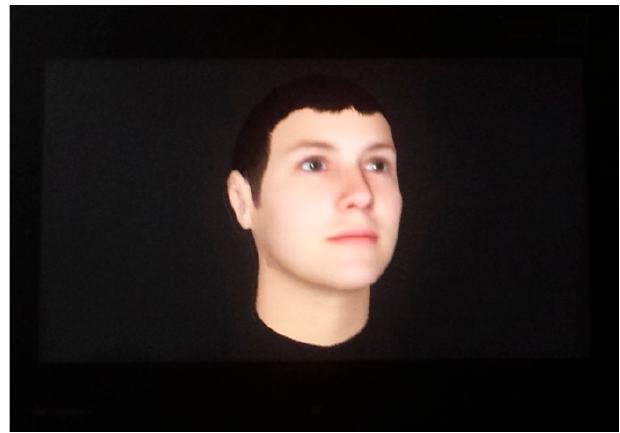
Figure 10. The Virtual Butler